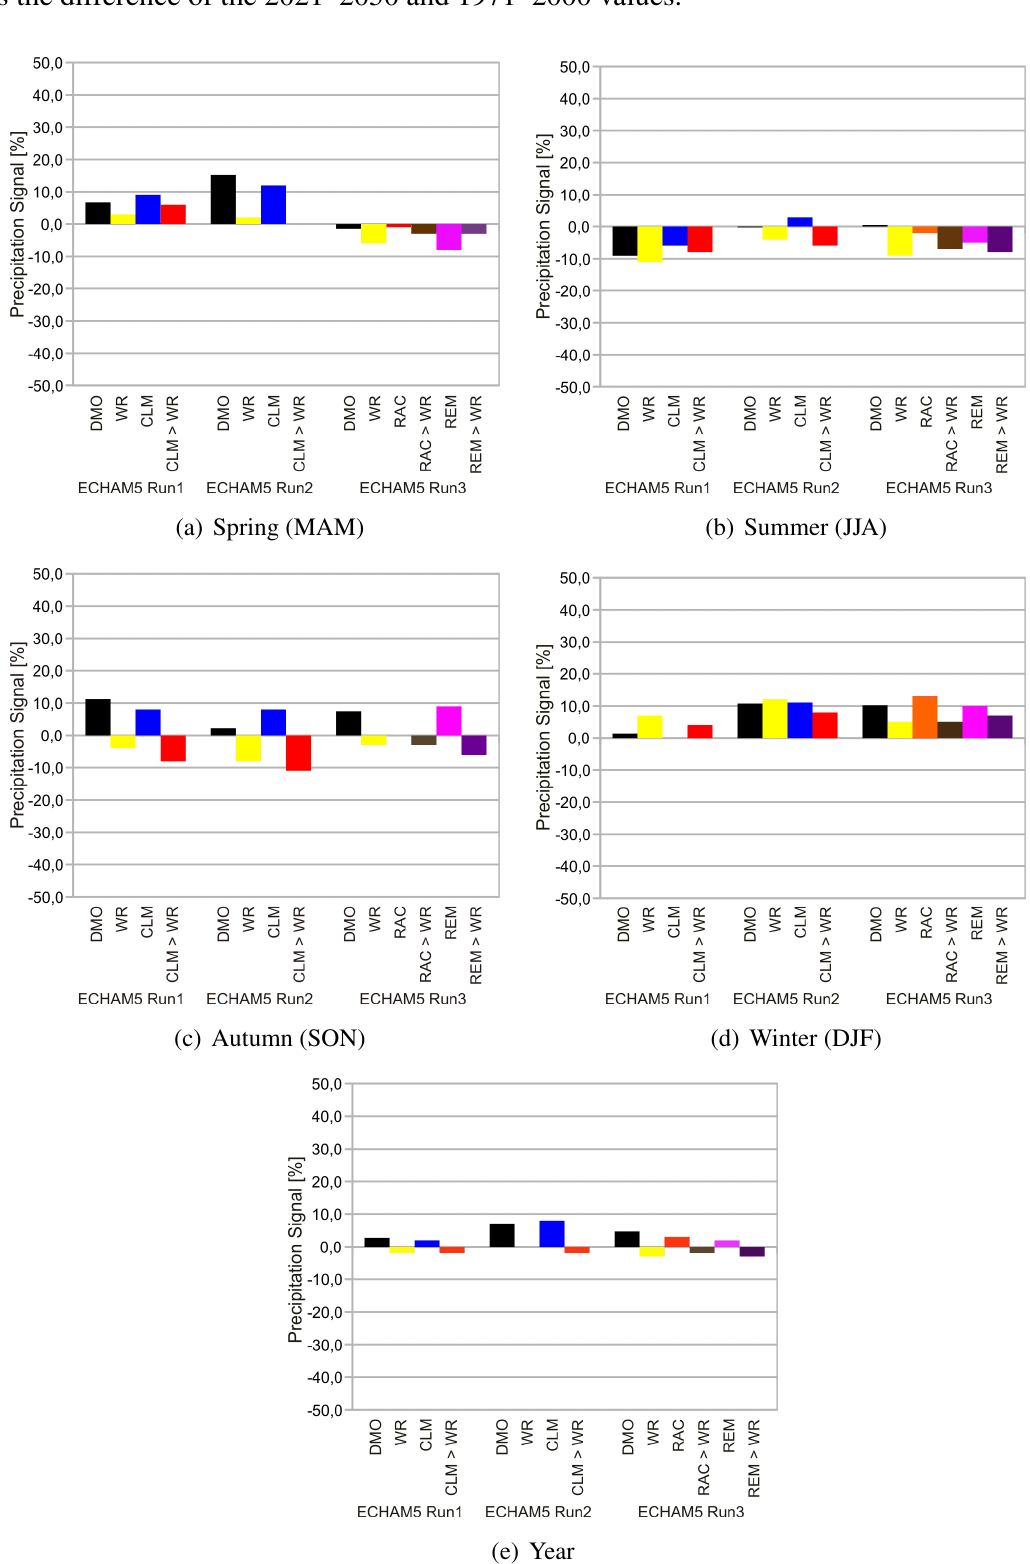
Figure 5. Comparison of the climate signals of precipitation (percentual change), computed as the difference of the 2021–2050 and 1971–2000